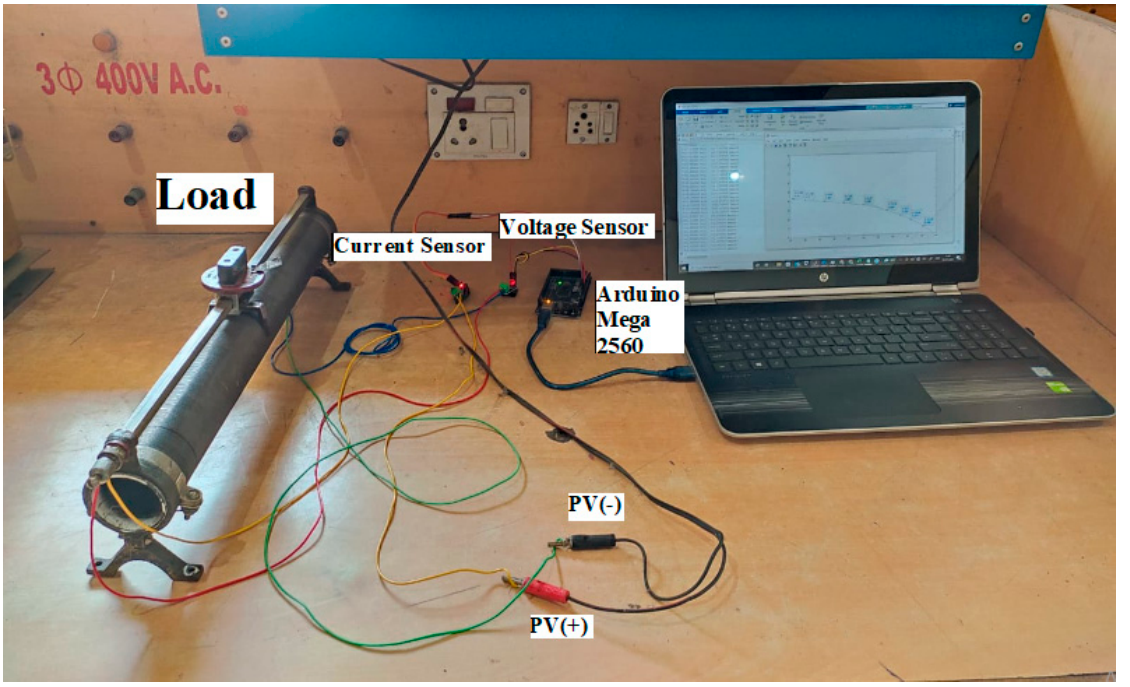
Figure 14. Experimental setup for obtaining the PV curve for Module AS ‐ M3607 ‐ S (G1 CELLS).